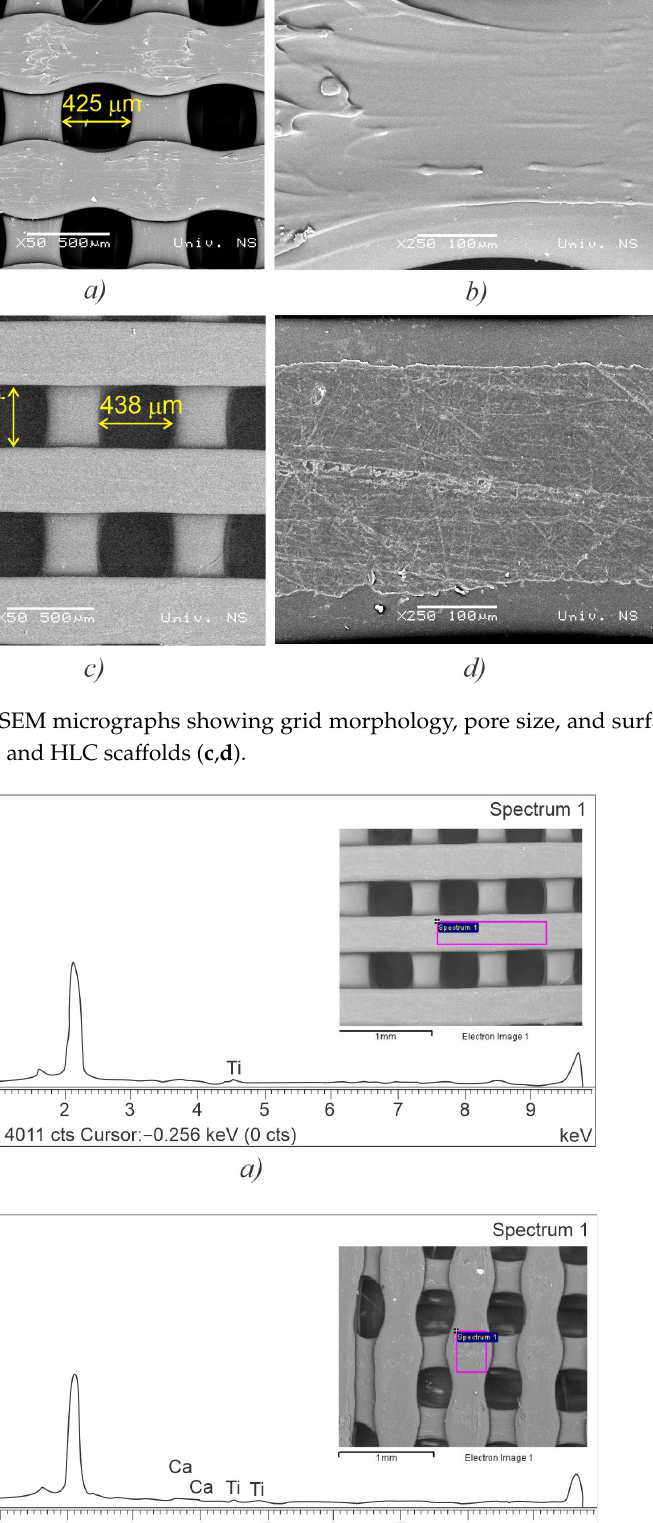
Figure 5. EDS elemental composition values [Wt.%] for ( a ) LLC and ( b ) HLC scaffolds.